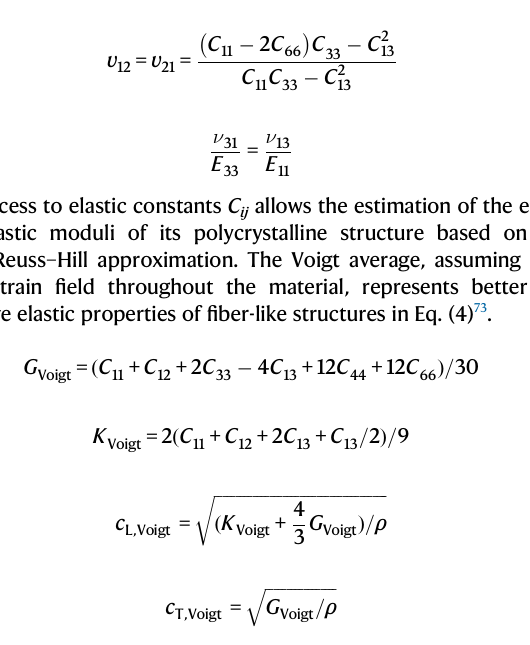
The computed longitudinal (transverse) sound velocities of poly- domain LCE, c L(T),Voigt =2460(1200)m/s, agree very well with the experimental values c L(T),exp =2430(1110) m/s (dashed lines in Fig.